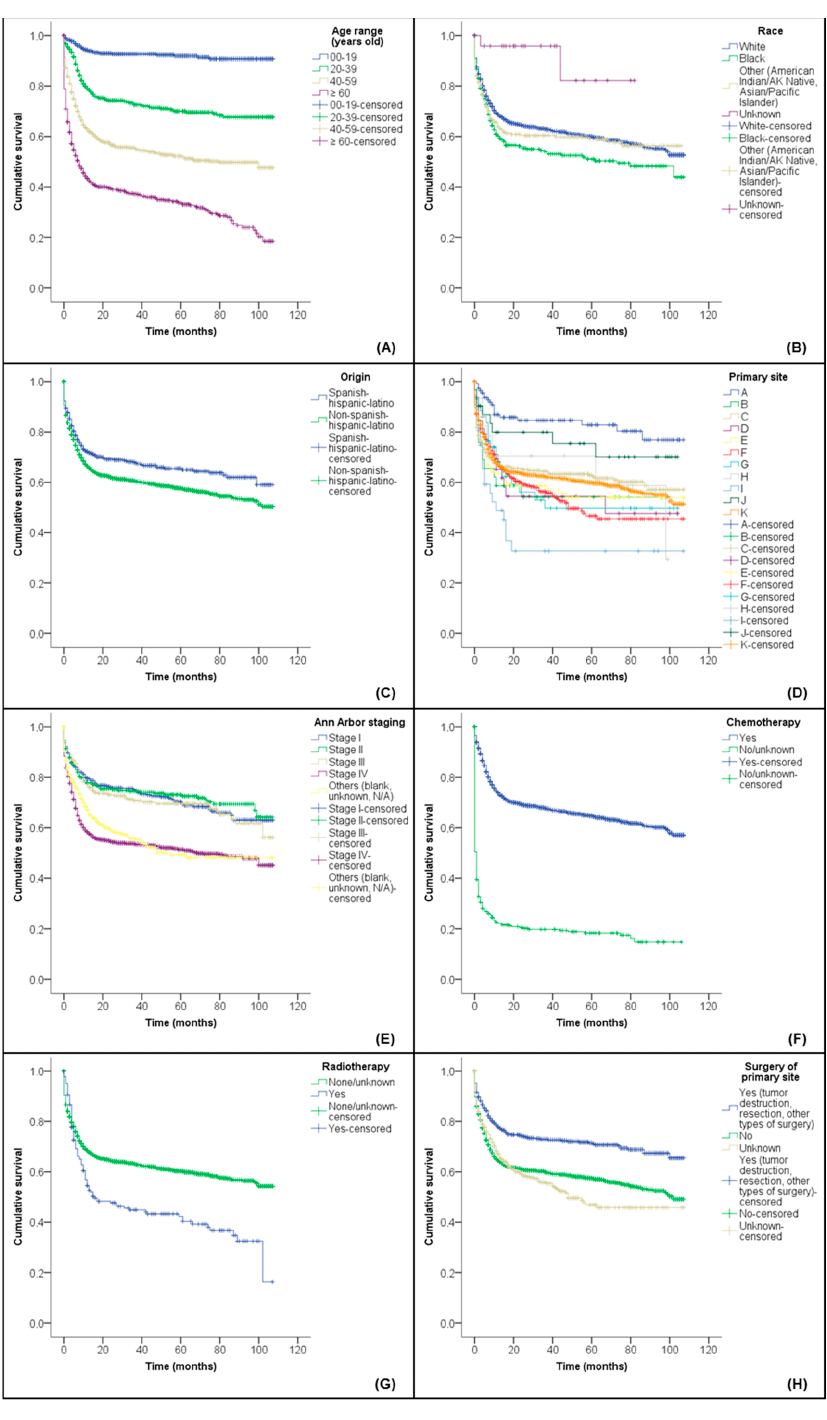
Figure 1. Cumulative survival probability from BL/L according to ( A ) age range, ( B ) race, ( C ) origin, ( D ) primary site, ( E ) Ann Arbor staging, ( F ) chemotherapy, ( G ) radiotherapy and ( H ) surgery of the primary site. Abbreviations: BL/L, Burkitt lymphoma/leukemia; CNS, central nervous system; GIT, gastrointestinal tract; N/A, not applicable. Notes: all variables were significant ( p -value < 0.05) for all three statistical tests (Breslow (Generalized Wilcoxon), Tarone–Ware and log rank (Mantel–Cox)) applied in the analyses. The captions for the ‘primary site’ variable groups (Figure 1D) are as follows: A, lip, oral cavity and pharynx; B, unknown primary site and other and ill-defined sites; C, GIT and attachments; D, respiratory system and cardiac system and attachments; E, skin, bones, joints, articular cartilage and other tissues/sites; F, hematopoietic and reticuloendothelial systems; G, breast and female/male genital organs; H, urinary system; I, eye, adnexa, brain and other parts of the CNS; J, glands (thyroid and adrenal); K, lymph